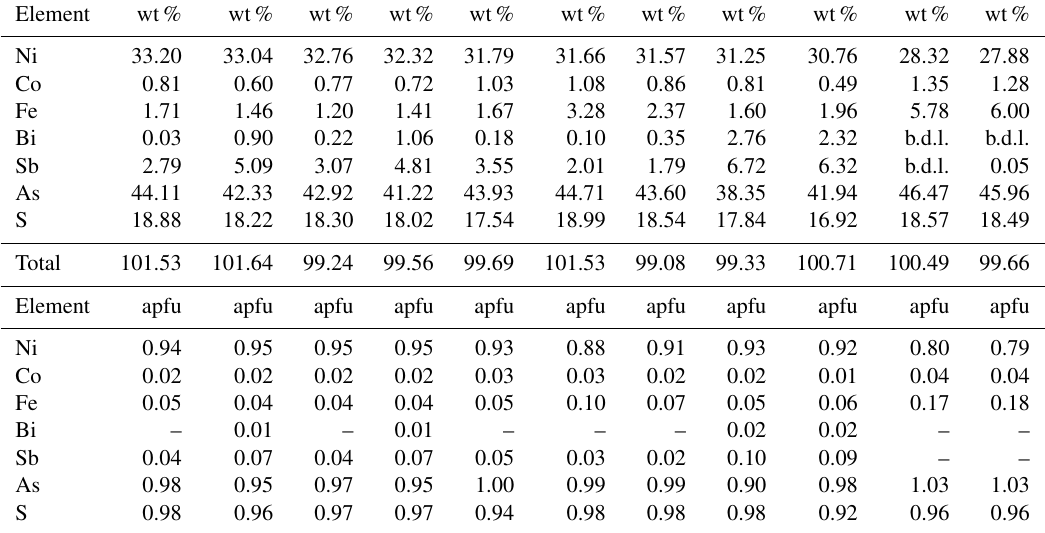
Table 1. Selected electron microprobe analyses of gersdorffite. Element